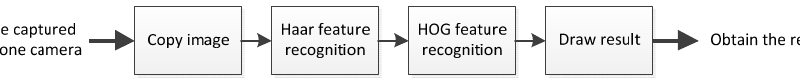
Figure 10. Feature recognition module operating procedure.